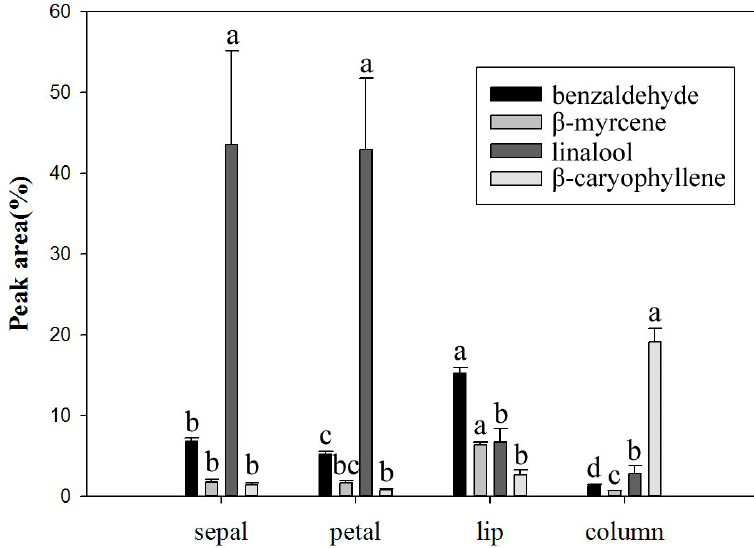
Figure 4. Changes in the major volatile components of different parts of Onc. Rosy Sunset (Different letters indicate significant differences at p < 0.05 by LSD multiple range).